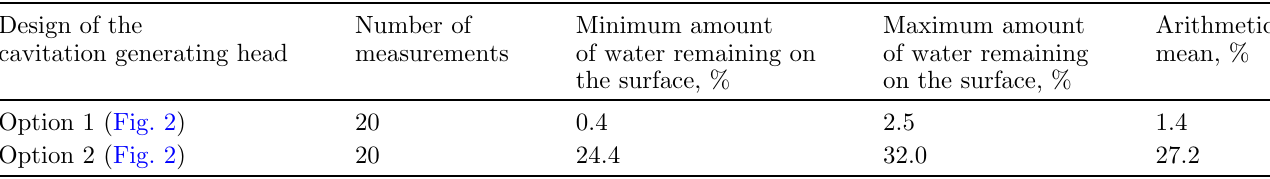
Table 2. Statistical results of the experimental data. Design of